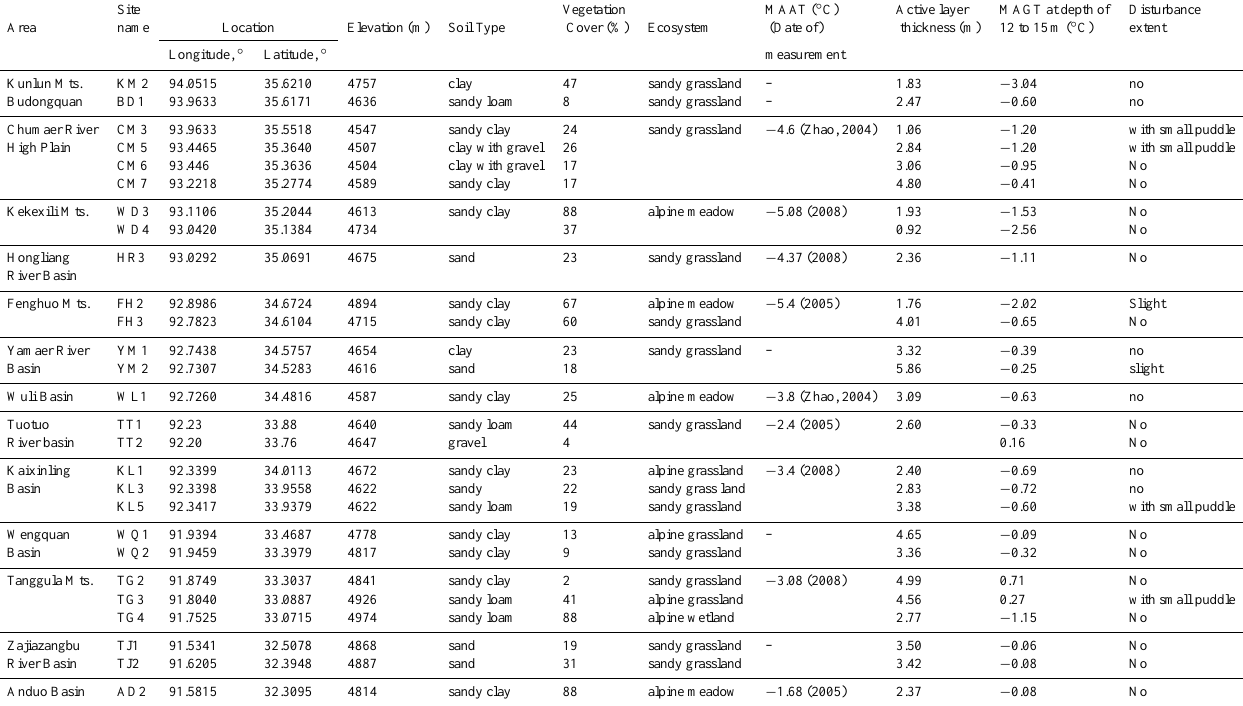
Table 1. Geographical data and information on the 27 sites along the QXR from 2006 to 2010.